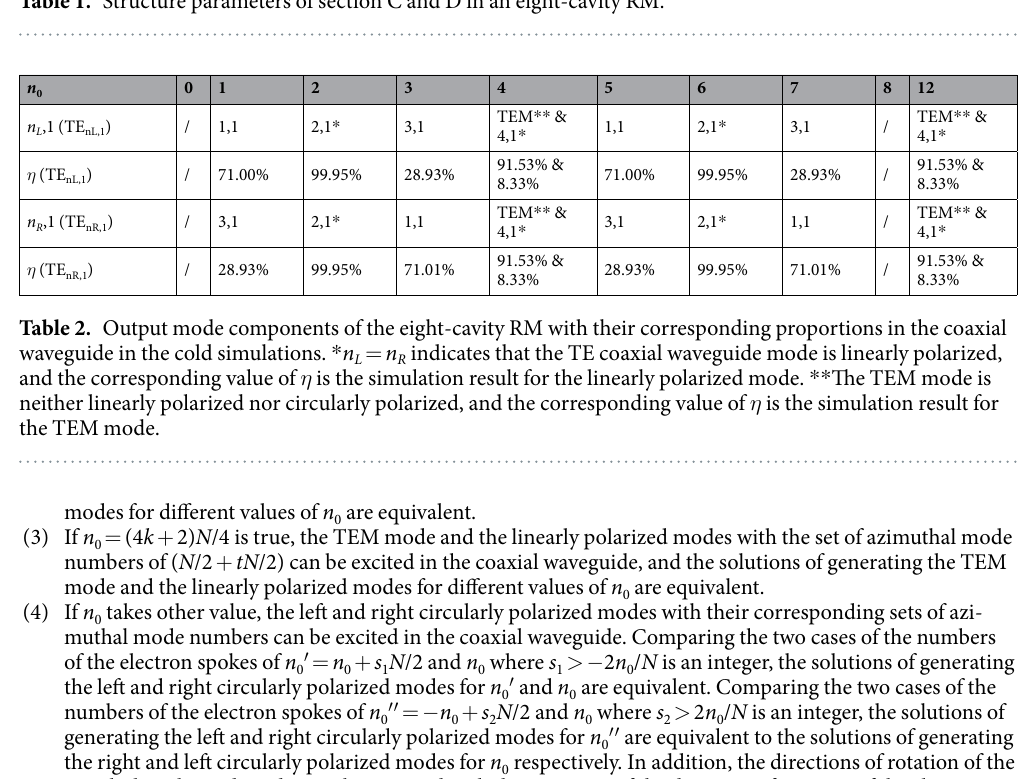
Table 1. Structure parameters of section C and D in an eight-cavity RM.